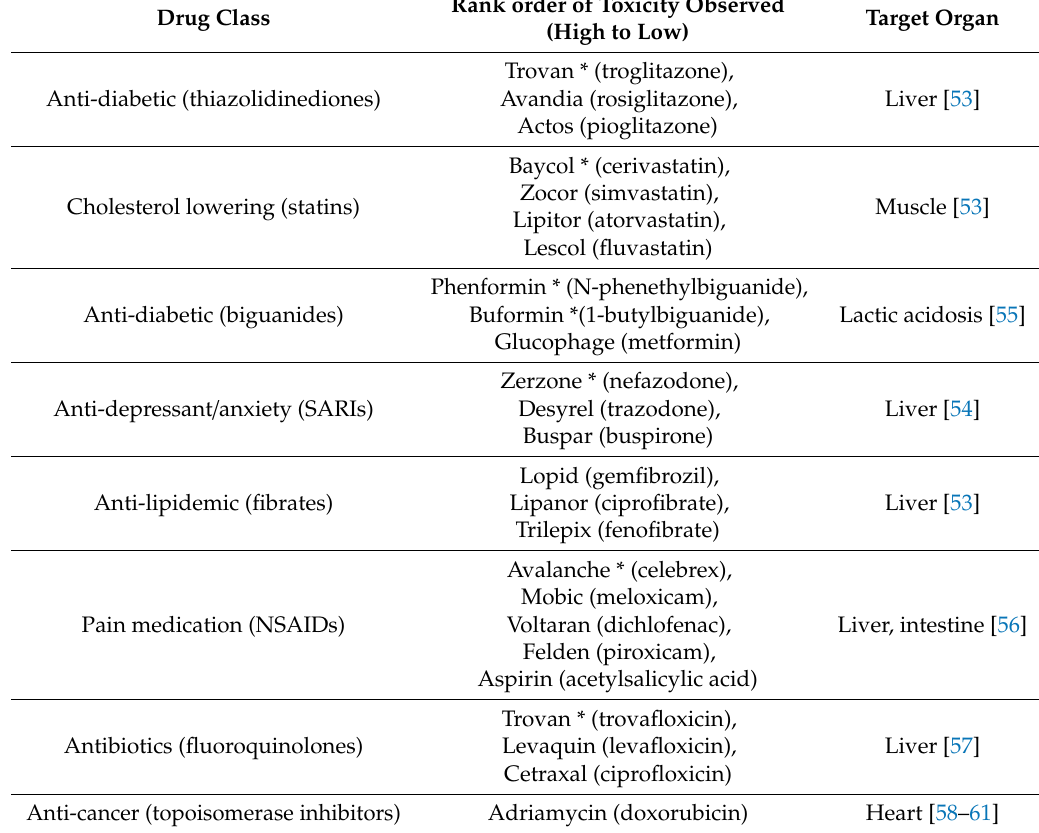
Table 1. Each drug class contains drugs with more and less observed mitochondrial